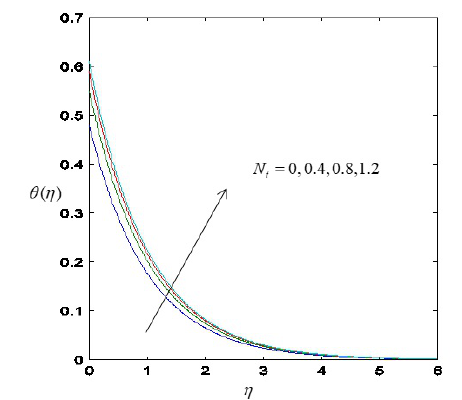
Fig. 10: . Influence of Thermophoresis parameter N t on θ ( η )